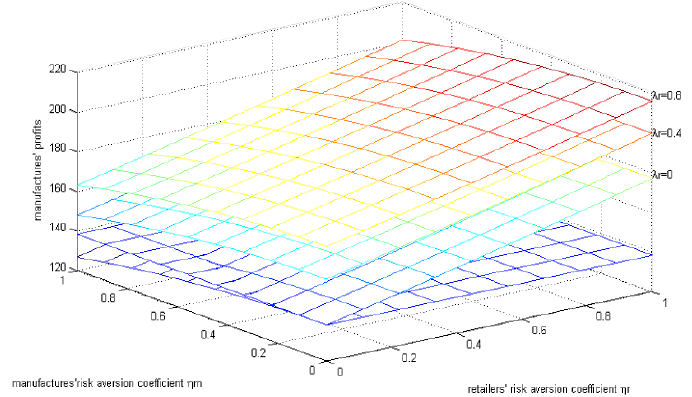
Figure 6. The effects of the risk aversion coefficient and fairness concern coefficient on the manufacturer’s profits.